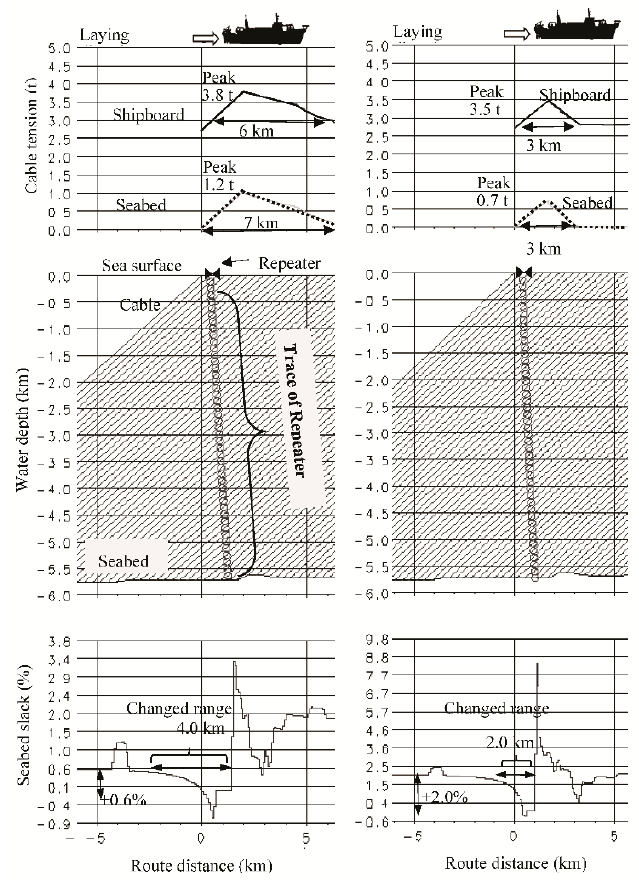
Figure 14. Comparison of simulation results, laying repeater when additional slack is different.